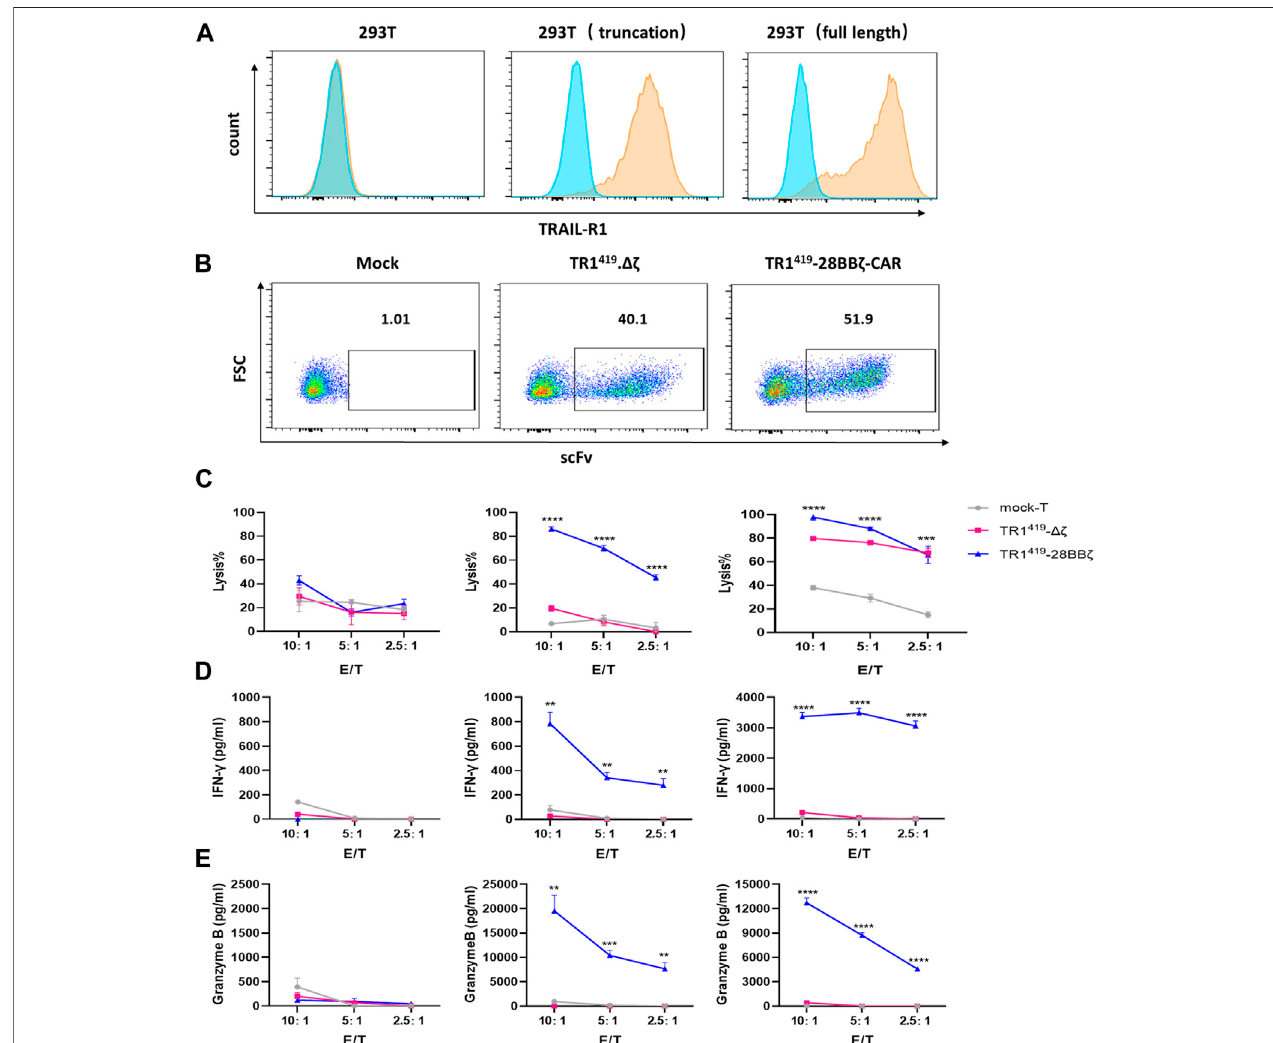
FIGURE 4 | TR1 419 -28BB ζ CAR-T cells mediated dual antitumor effects. (A) 293T cells were transfected with the lentiviral plasmids expressing the full length or truncated TRAIL-R1. Then the expression of both types of exogenous TRAIL-R1 in 293T cells was determined by fl ow cytometry. (B) Mock T, TR1 419 -28BB ζ CAR-T cells, or TR1 419 Δζ -T cells were evaluated for the TR1 419 scFc expression by fl ow cytometry. (C) Cytotoxic activity of TRI419-28BB ζ CAR- and TR1 419 Δζ -T cells were determined against 293T; 293Texpressing truncated TRAIL-R1and 293T withthe wild type TRAIL-R1, by RTCA assay. IFN- γ (D) and granzyme B (E) production by TR1 419 -28BB ζ CAR-T cells or TR1 419 Δζ -T cells was detected by ELISA, after cocultured with the indicated target cells for 24 h. Data are represented in the mean ± SEM of three triplicate wells. * p < 0.05, ** p < 0.01 and *** p < 0.001.